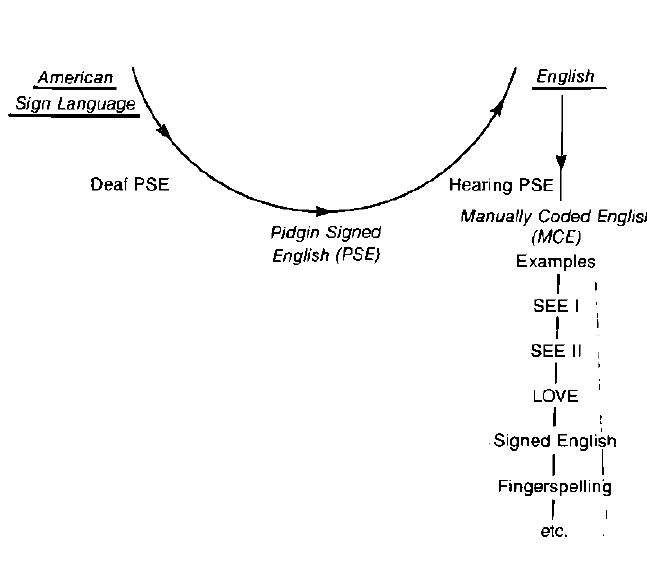
Figure 1 American Sign Language Continuum (after Woodward,